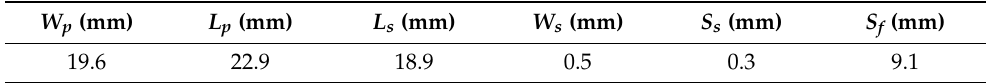
Table 2. Critical dimensions of the designed feed